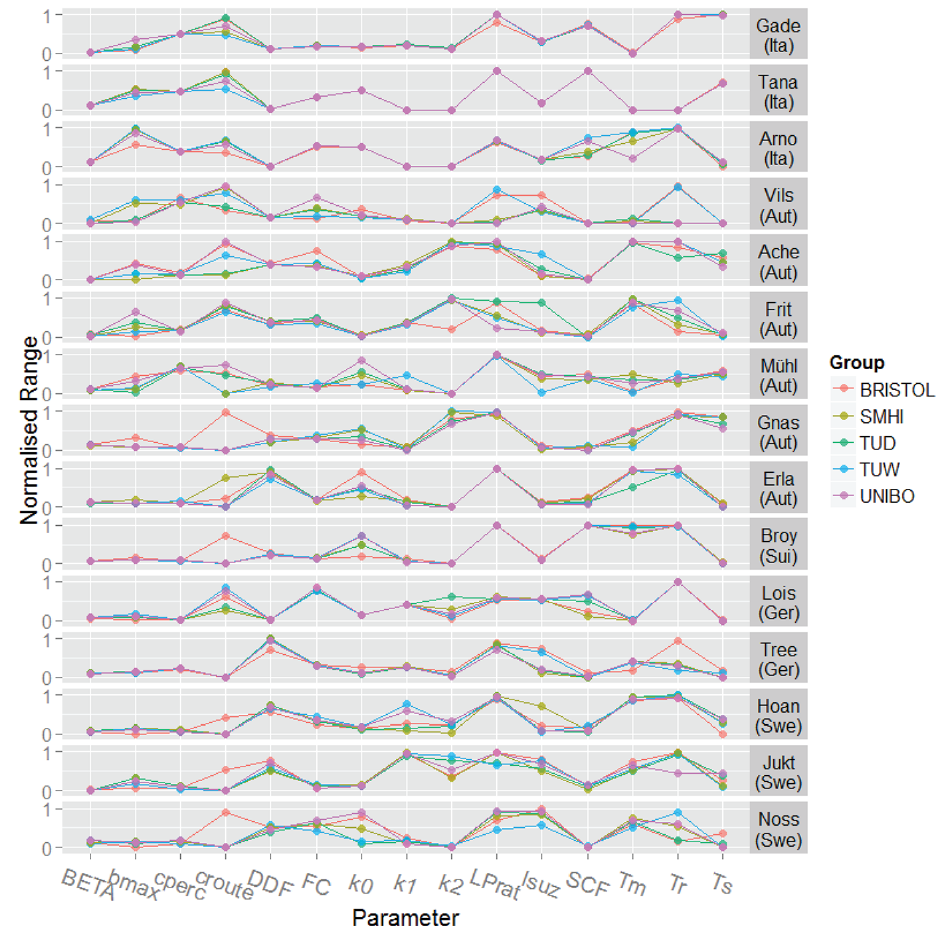
Figure 3. Parallel coordinate plots of the optimal parameter set estimates derived from each participant group in each of the 15 catchments for Protocol 1. Model parameters are shown on the x axis and catchments on the right-hand y axis. The parameters have been scaled to the ranges shown in Table